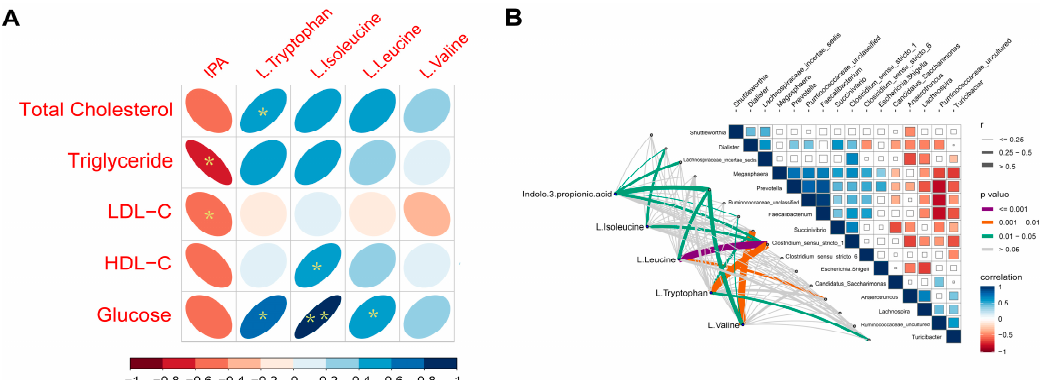
Figure 6. ( A ) Spearman’s correlation matrix of branched-chain amino acids (BCAA), L-trypotophan, indole-3-propionic acid (IPA) and lipid parameters and glucose in growing pigs fed a diet with or without a 5% inulin supplement. The direction of ellipses represents positive or negative correlations and the width of ellipses represents the strength of correlation (narrow ellipse = stronger correlation). IPA, indole-3-propionic acid. * p < 0.05; ** p < 0.01; ( B ) Pairwise comparisons of cecal genera are shown with a color gradient denoting Spearman’s correlation coefficient. IPA, L-isoleucine, L-leucine, and L-tryptophan was related to each microbial genus by partial Spearman tests. Edge width corresponds to the Partial Spearman’s r statistic for the corresponding distance correlations and edge color denotes the statistical significance.